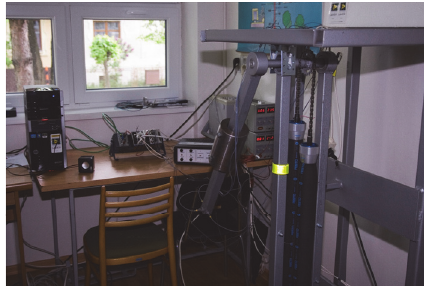
Figure 4: Experimental device with a drive based on the PAMs.